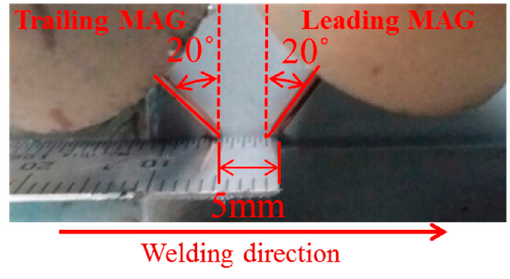
Figure 2. Wire angle and distance of tandem MAG welding process.